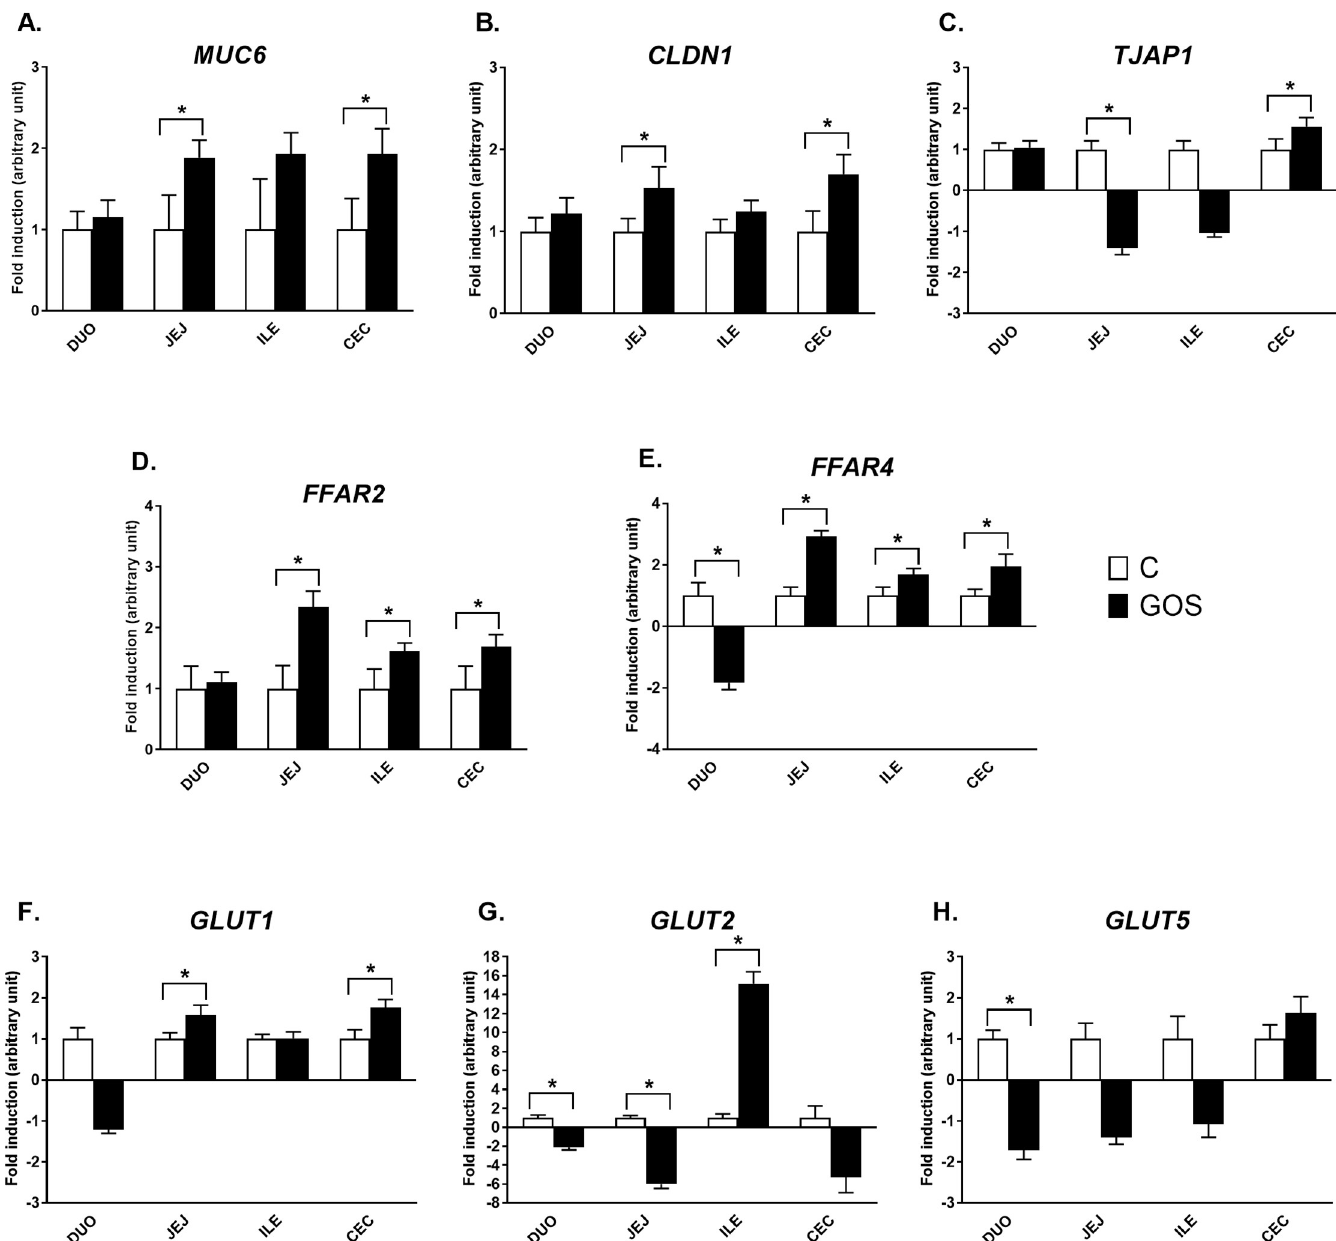
Fig 4. Relative mRNA expression of barrier function and nutrient sensing genes in different segments of intestinal mucosa in chickens injected in ovo with GOS. The panel includes genes encoding mucin, (A) MUC6 ; tight junctions components, (B) CLDN1 and (C) TJAP1 ; free fatty acid receptors, (D) FFAR2 and (E) FFAR4 ; and glucose transporters, (F) GLUT1 , (G) GLUT2 and (H) GLUT5 . Intestinal segments: DUO–duodenum, JEJ–jejunum, ILE–ileum and CEC–caecum. In ovo treatment groups: control (white bars)–injected in ovo with physiological saline; GOS (black bars)–injected in ovo with galactooligosaccharides. In ovo injection was carried out on day 12 of egg incubation. Intestinal samples (n = 10) were collected from chickens on day 42 post-hatching. RT-qPCR data were generated with custom-designed primers used for amplification with SYBR green dye; Glucose-6-phosphate dehydrogenase ( G6PDH ) and beta-actin ( ACTB ) were used as reference genes; relative gene expression calculated as 2 – ΔΔ Ct; Two-way ANOVA with a post hoc HSD Tukey test was used to compare the groups. Asterisk indicates pair-wise significant differences ( P < 0.05). The results of fold induction less than 1 have been transformed by the formula -1/fold